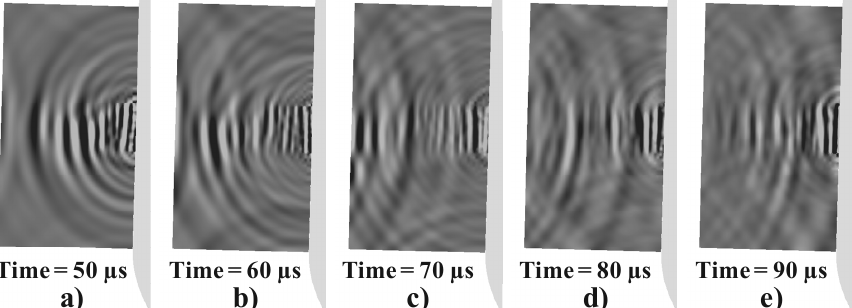
Figura 18: Mappe di pressione nella sezione centrale della porzione di aria tra la superficie della rotaia e il trasduttore per il modello in cui è imposta la condizione di contorno riflettente nell’intervallo di tempo da 50  10 -6 a 90  10 -6 secondi.